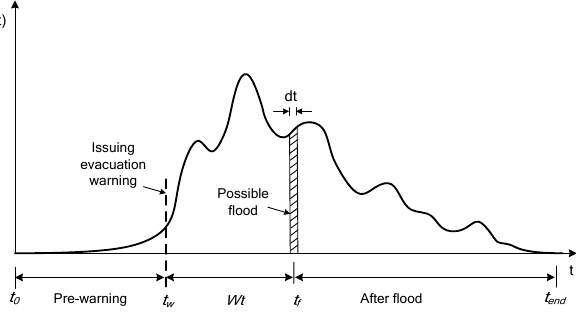
Fig. 5. Probability of dam-break flood as a continuous stochastic process of time